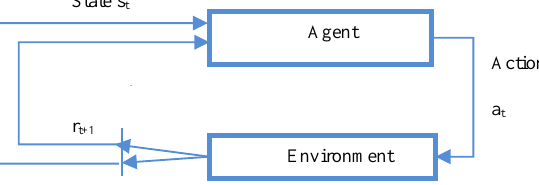
Figure 1. The framework of reinforcement learning